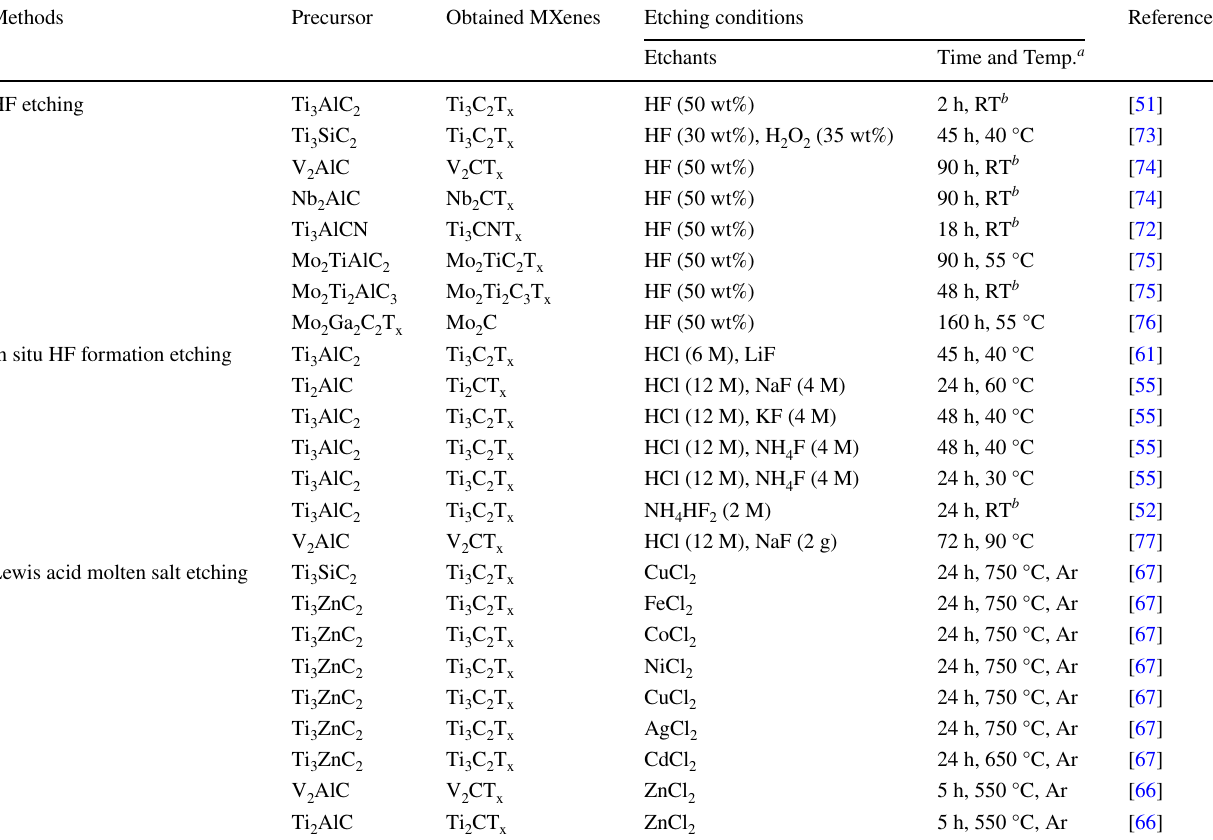
a Temp.: temperature; b RT: room